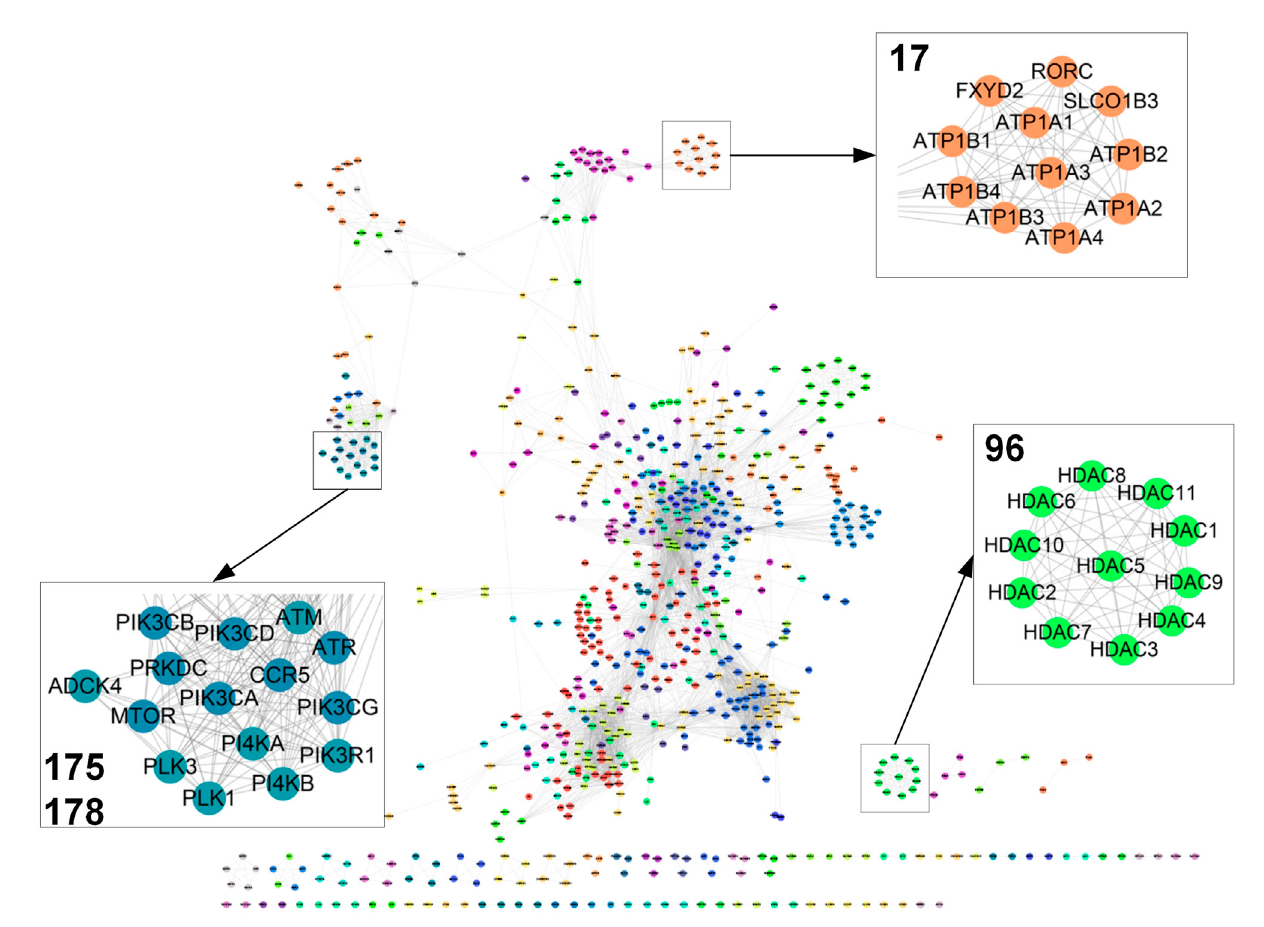
FIGURE 2 Target network. Part of the target map with 5,000 links were displayed (see more details in Supplementary Table S4). Clusters 17, 96, 175, and 178 were magni fi ed (see more details in Supplementary Table S5).